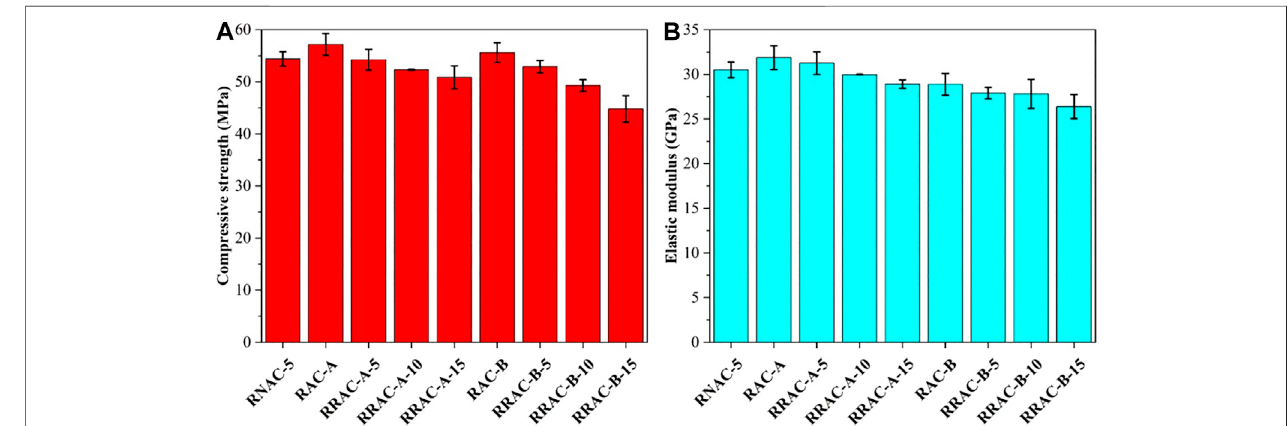
FIGURE 4 | (A) Compression strength (B) Elastic modulus of RNAC and